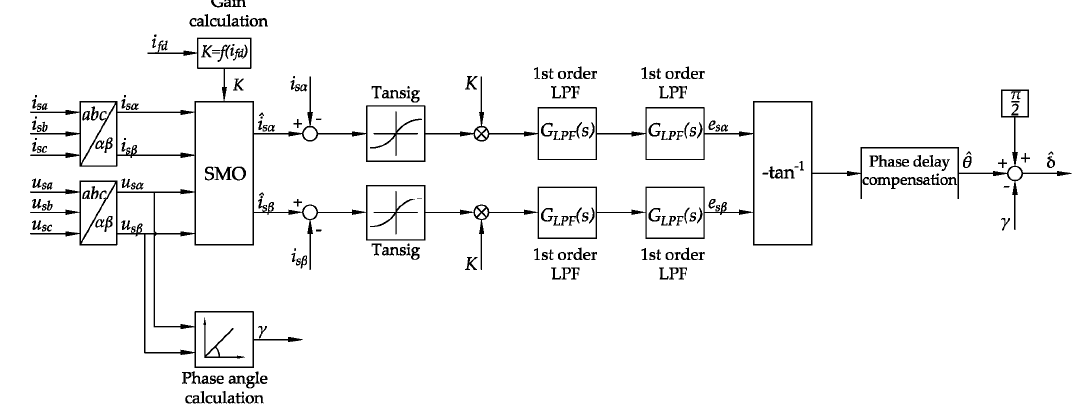
Figure 2. Structure of the proposed sliding mode observer (SMO) based load angle estimator.